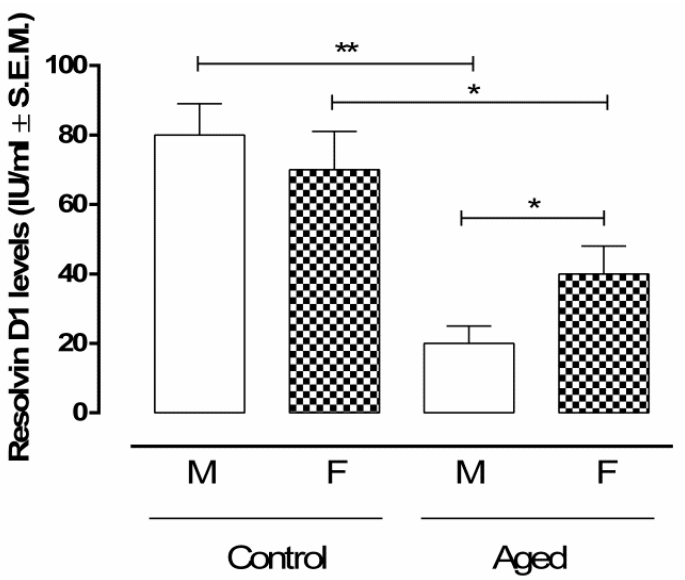
Figure 1. RvD1 retinal levels. ELISA determination of RvD1 in aged and younger (control) retina. Data are expressed as mean ± S.E.M. of N = 10 retinas per group. M: males; F: females; IU: Interna- tional Units; ** p < 0.01; * p < 0.05 vs. control.